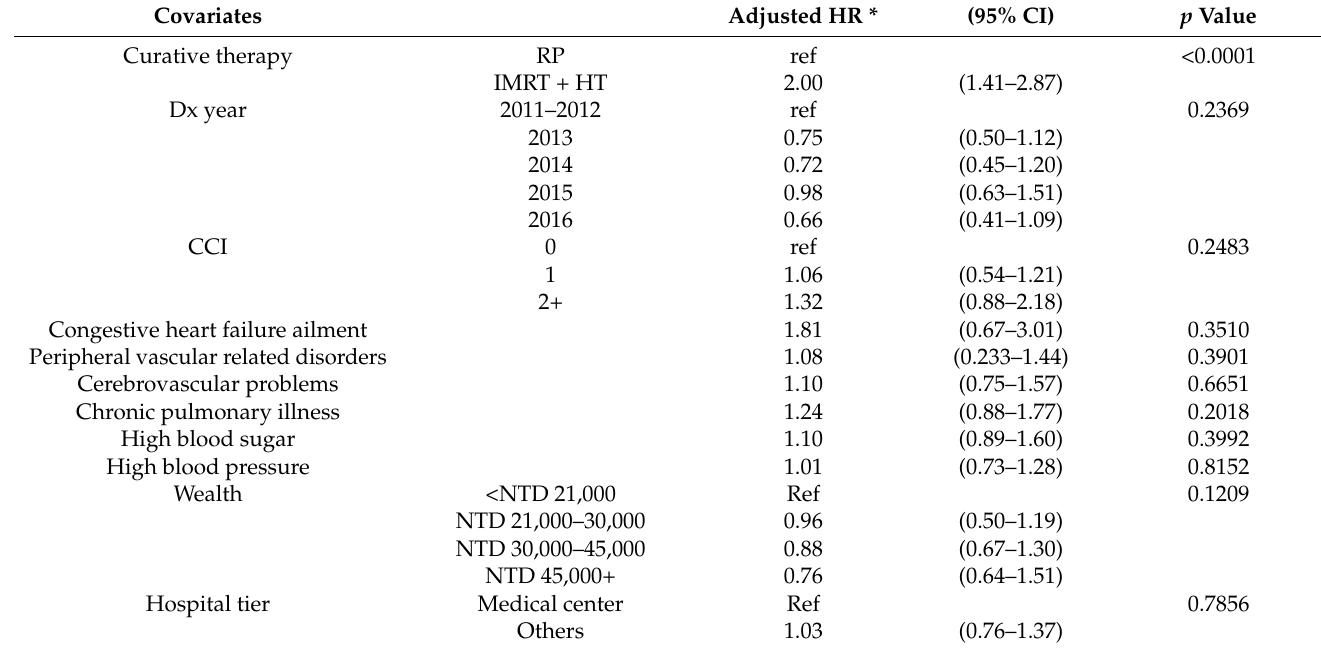
Table 1. The AV-LPC statistics of all-cause death: Multivariate Cox regression model.